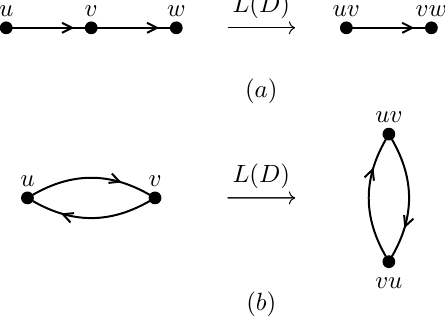
Figure 1: The line digraph